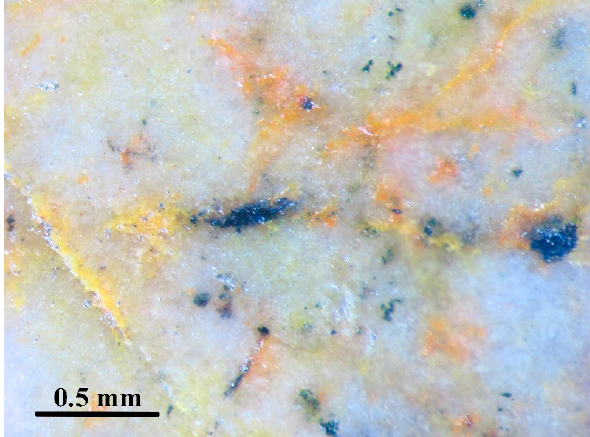
Figure 1. Black elongated grain of tsygankoite with metallic lustre and alabandite (in the center) in white dolomite–calcite matrix along with orpiment (yellow) and native arsenic (black rounded grain on the right). This grain of tsygankoite was extracted from the polished section and used for the structure data collection.